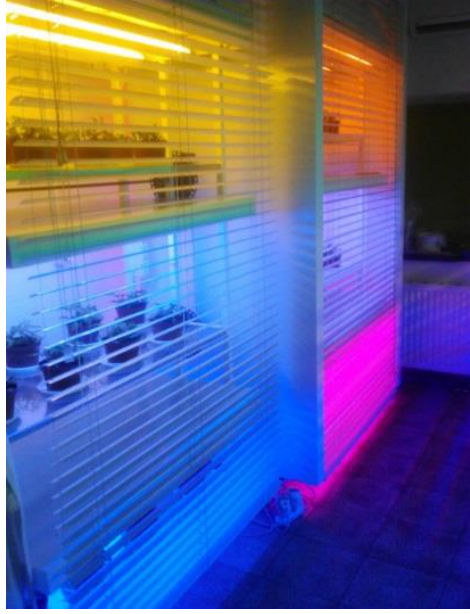
Figure 1. Three-layer shelf system in growth room.